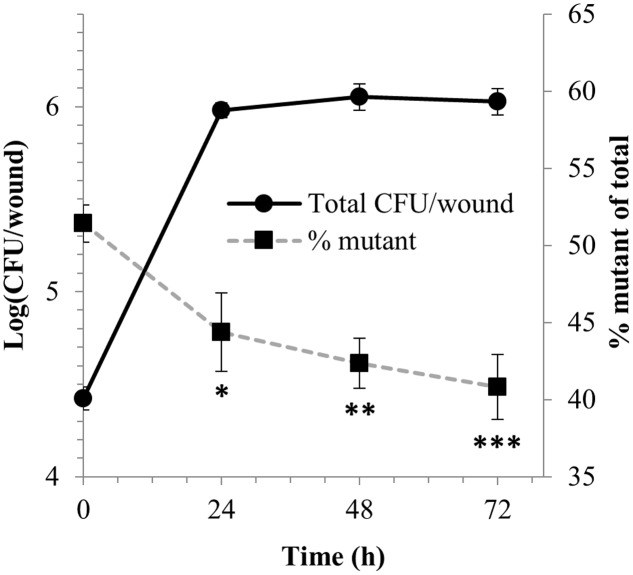
Competitive fitness of EcO157 WT and betTIBA-otsBA mutant in leaf wounds on live lettuce plants. Total EcO157 population size per single wound per leaf () and percentage of the betTIBA-otsBA mutant in the total EcO157 population () after their co-inoculation during wounding of leaves on whole potted lettuce plants. All values represent mean determinations from five (immediately after inoculation) and ten (during incubation) leaf wound disks sampled from random leaves and random plants. ∗, ∗∗, and ∗∗∗ indicate significant difference in the % of mutant over total EcO157 cells at 24, 48, and 72 h compared with the initial % at the time of inoculation (0 h), as per Dunnett’s multiple comparison test on transformed % data, with P < 0.05, 0.01, and 0.005, respectively. Error bars, standard error of the mean.